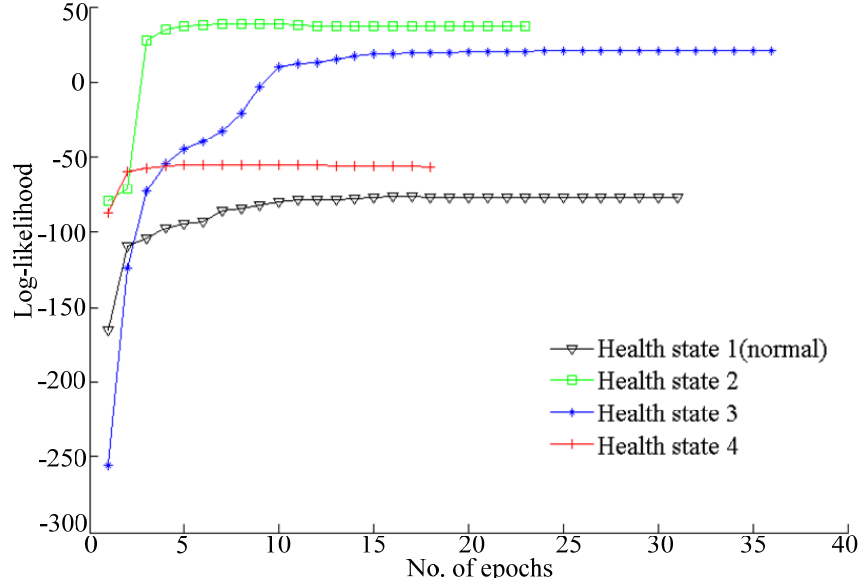
Figure 7. Log-likelihoods of HMMs during training for the four